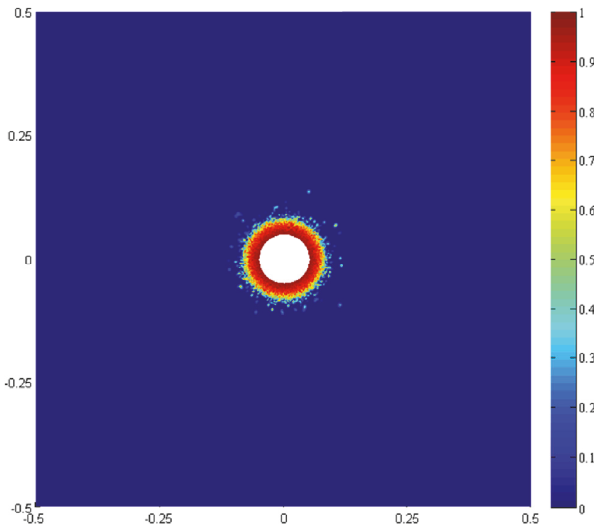
Figure 5: Damage distribution of borehole surrounding rock.